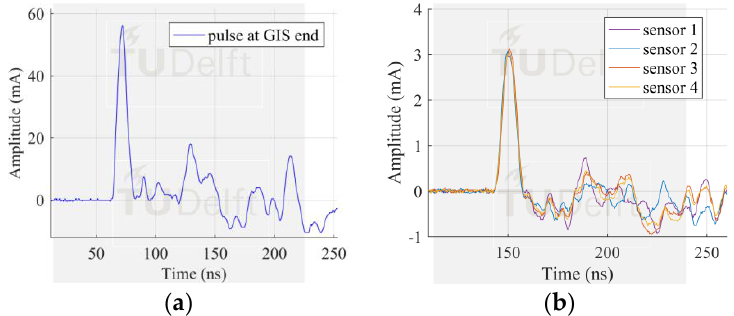
Figure 6. Results with configuration 2, ( a ) pulse injected at the test cell position; ( b ) pulses measured by HFCT 1. Four sensors installed and 12 current paths (remaining bolts). Sensors 2018 , 18 , x FOR PEER REVIEW